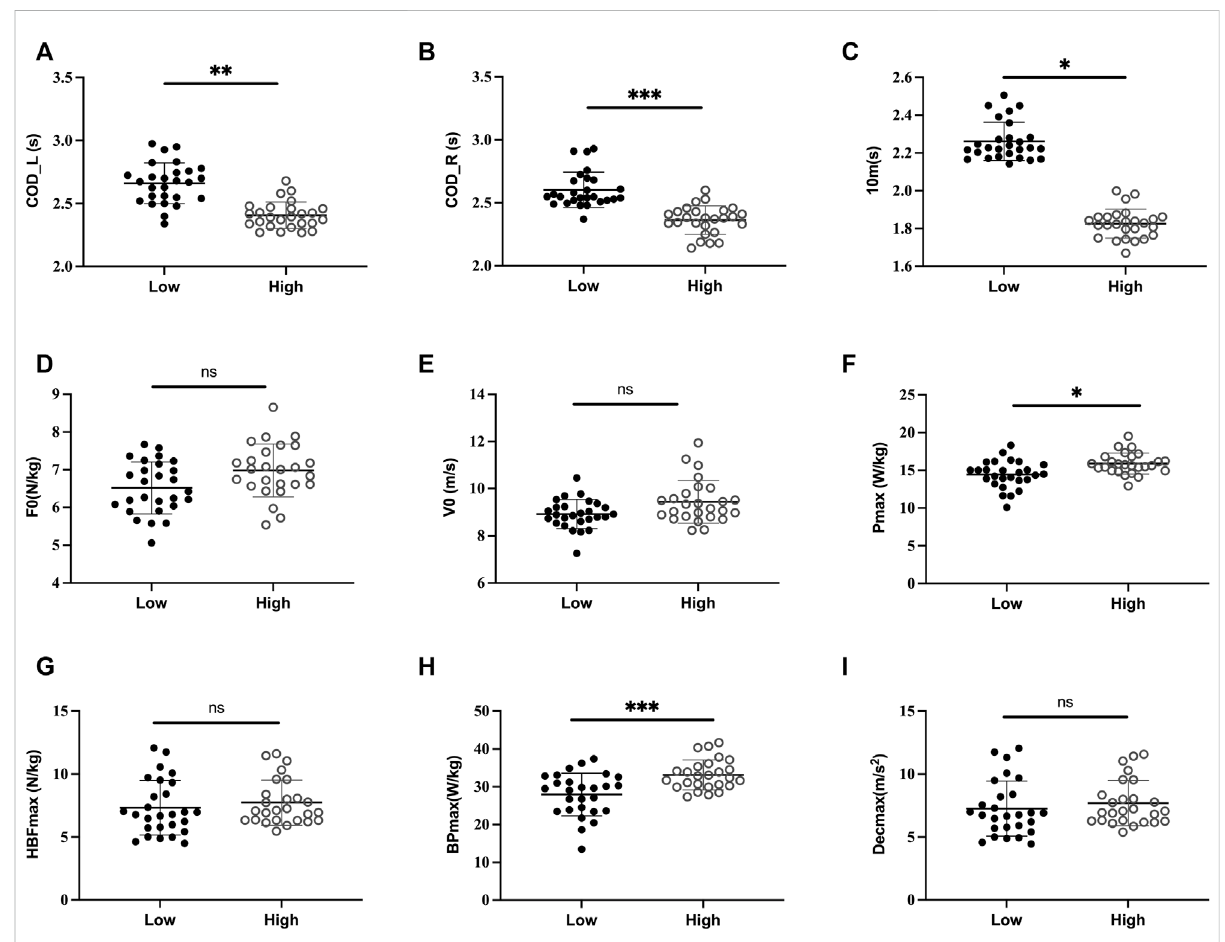
FIGURE 3 Two best multiple linear regressions for left side COD performance (COD_L) in male soccer players; 10 m: 10 m split time; HBP max : maximum braking power;